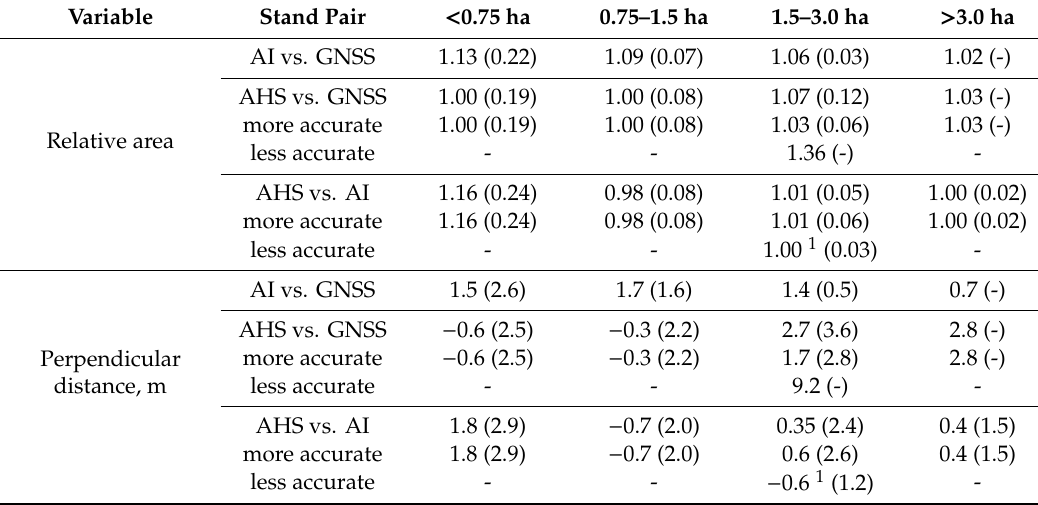
Table 6. The relative areas and perpendicular displacements for compared stands. The abbreviations are as in Tables 4 and 5. The standard deviations are given in parentheses, and missing values indicate that there was only one stand in that area